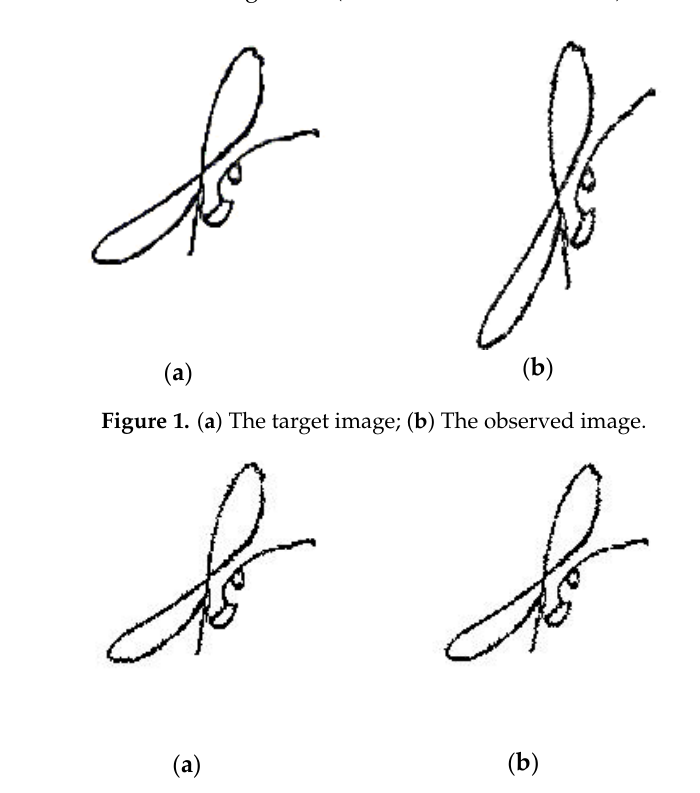
Figure 2. ( a ) The image obtained by ES-APSO2; ( b ) The image obtained by